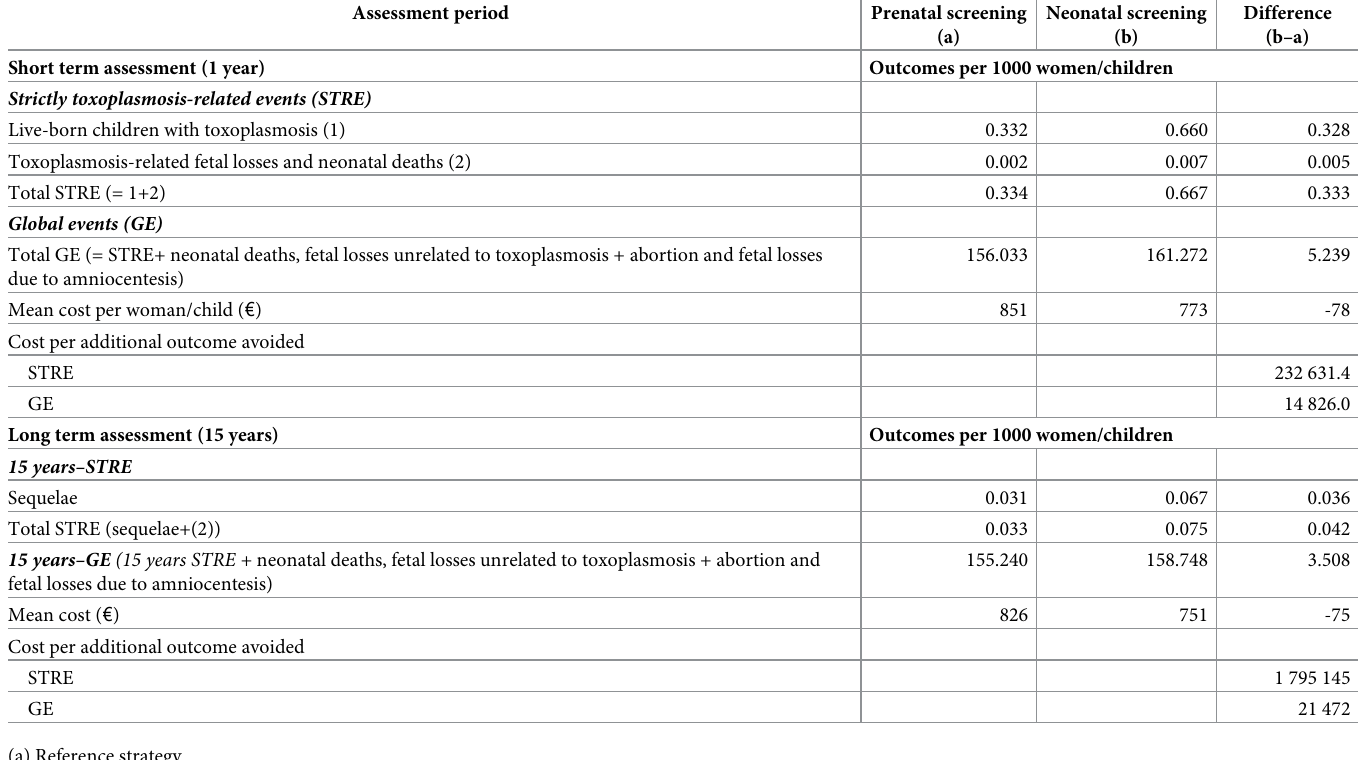
Table 3. Expected number of events, costs, and cost per additional outcome avoided (Toxoscreen